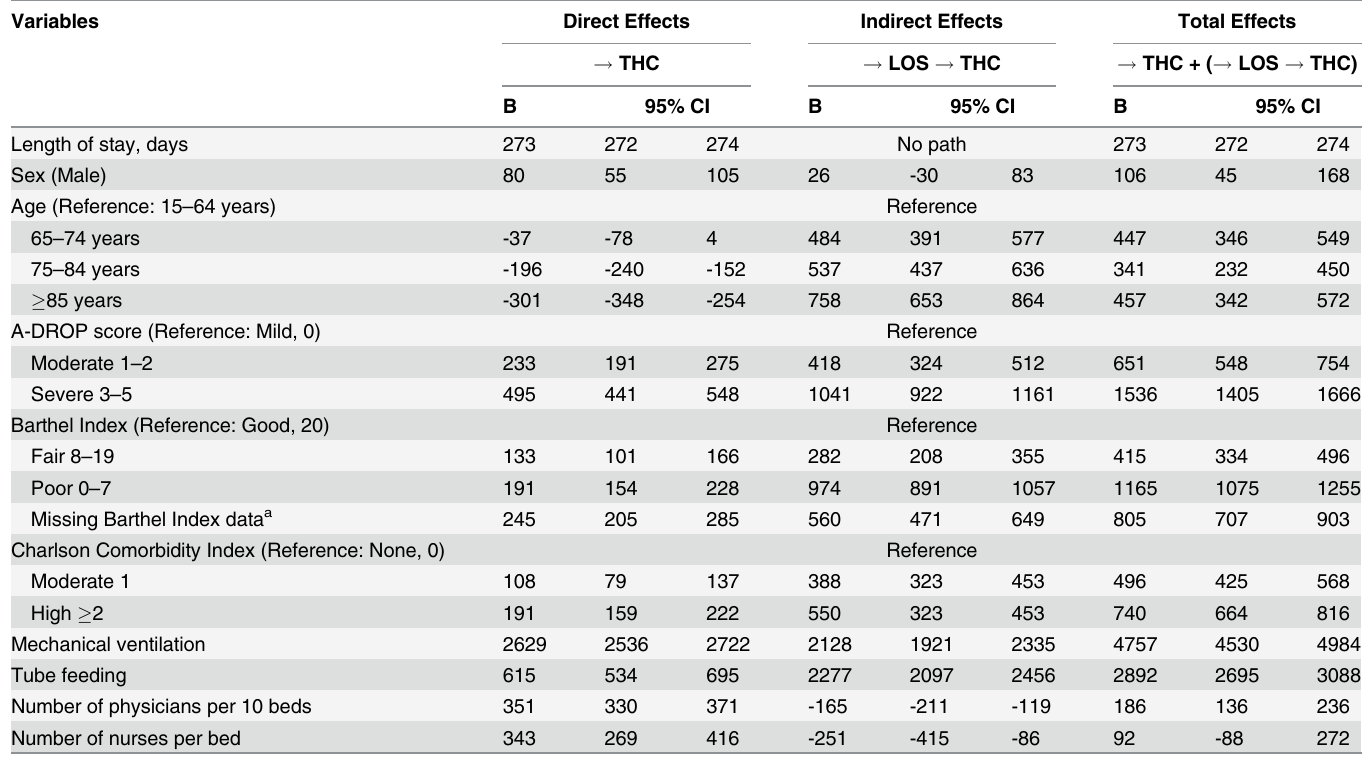
Table 3. Direct, indirect, and total effects of the factors on total hospitalization costs using a structural equation model (n =